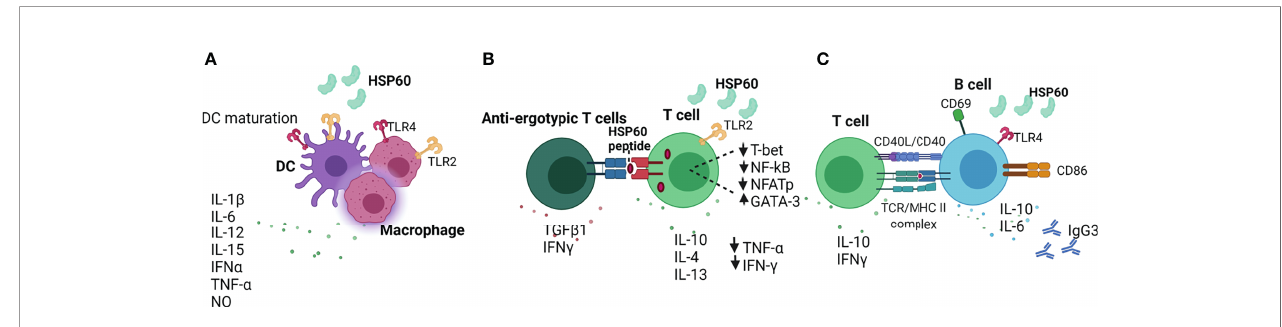
FIGURE 2 | Extracellular HSP60 immune network. (A) HSP60 induces DC maturation and secretion of in fl ammatory cytokines (140 – 142). (B) eHSP60 downregulates Th1-associated transcription factors (T-bet, NF-kB, NFATp) and upregulates GATA3, leading to decreased secretion of TNF- a and IFN- g and increased secretion of IL-10, IL-4, IL-13 (143). Activated T cells can present HSP60 via MHC molecules to anti-ergotypic T cells, leading to the production of IFN g and TGF b 1 by anti-ergotypic T regulatory cells (144). (C) HSP60 activates B cells via TLR4-MyD88 signaling pathway, leading to the production of IL-10, IL-6 and IgG3 (145). TLR4, Toll-like receptor 4; NO, nitric oxide, CD40L; CD40 ligand; TCR, T cell receptor; MHC II, major histocompatibility complex; IgG3, Immunoglobulin G3; Nf-kB; nuclear factor kappa B; NFAT, nuclear factor of activated T